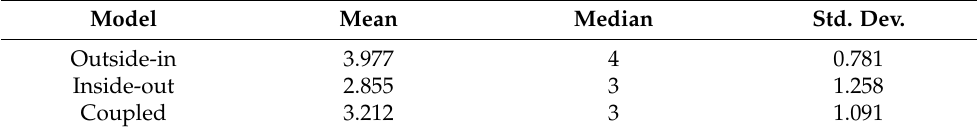
Table 4. Relevance of open-innovation practices.